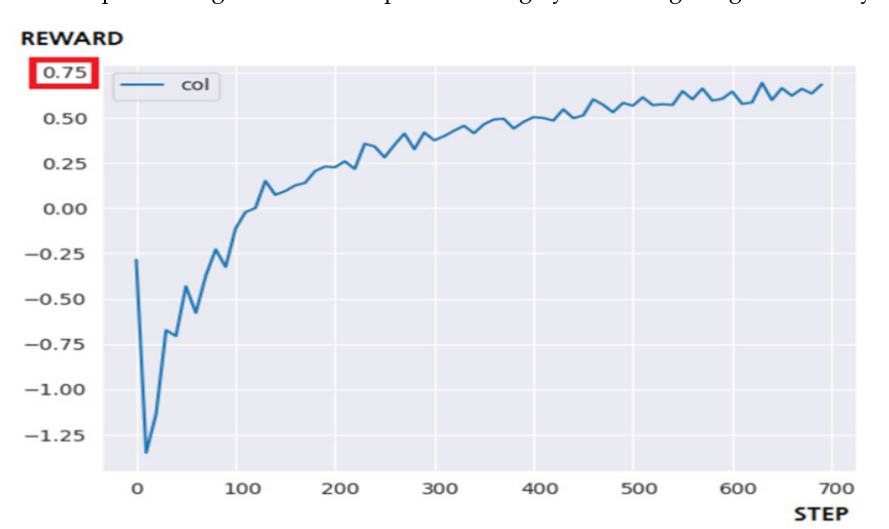
Figure 11. Result of 10 × 10 maze through